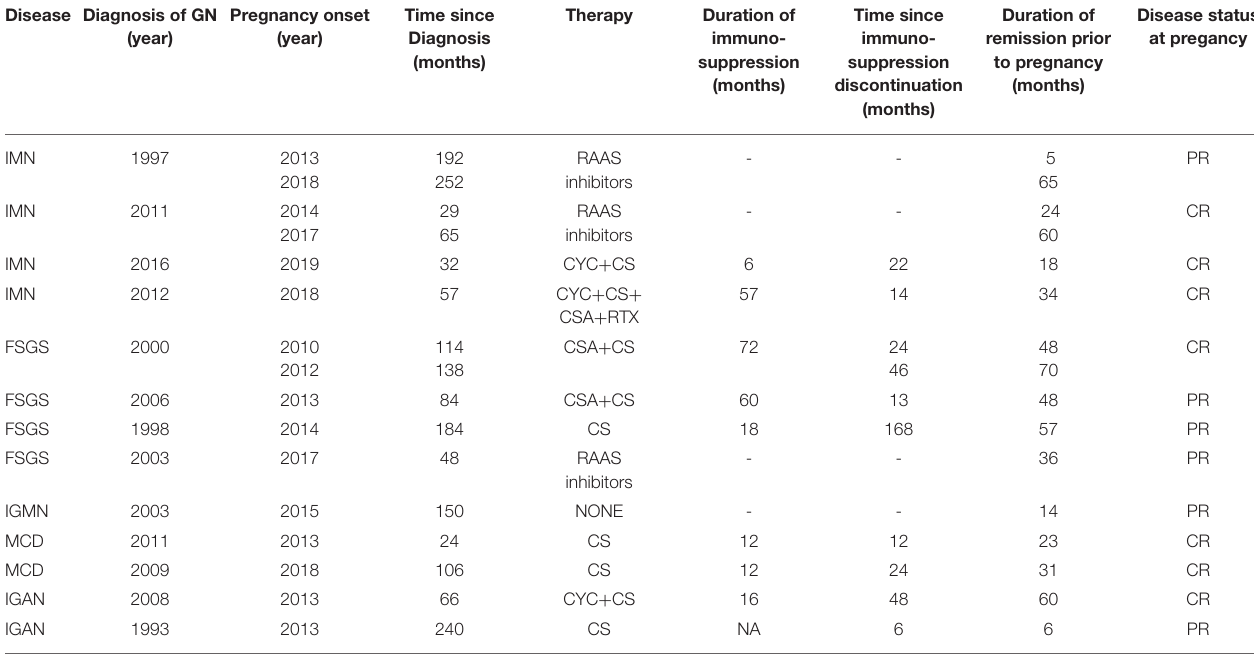
Therapy Duration of